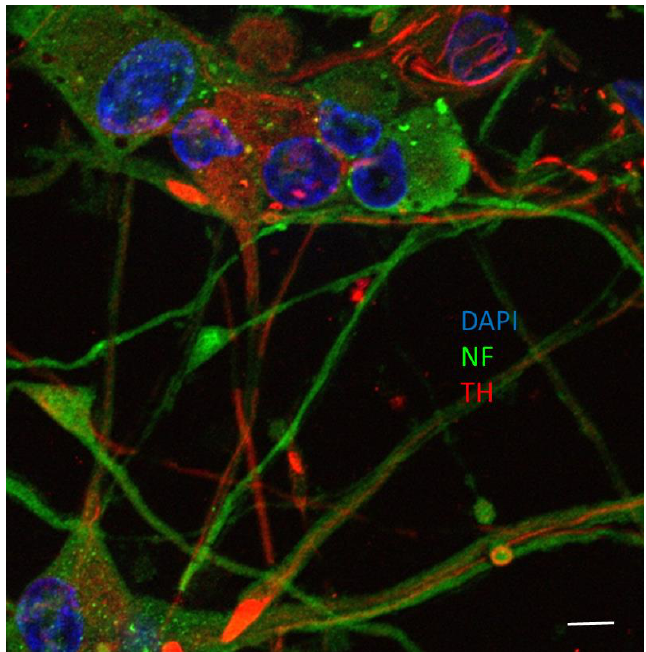
Figure 1. Representative microphotograph of nerve growth factor (NGF)-differentiated PC12 for 9 days by immunofluorescence. Nuclei are counterstained in blue with Dapi. NF: neurofilaments revealed with an anti-neurofilaments antibody (green). TH: tyrosine hydroxylase revealed with an anti-tyrosine antibody as a marker of dopamine (red). Scale bar = 10 µm.